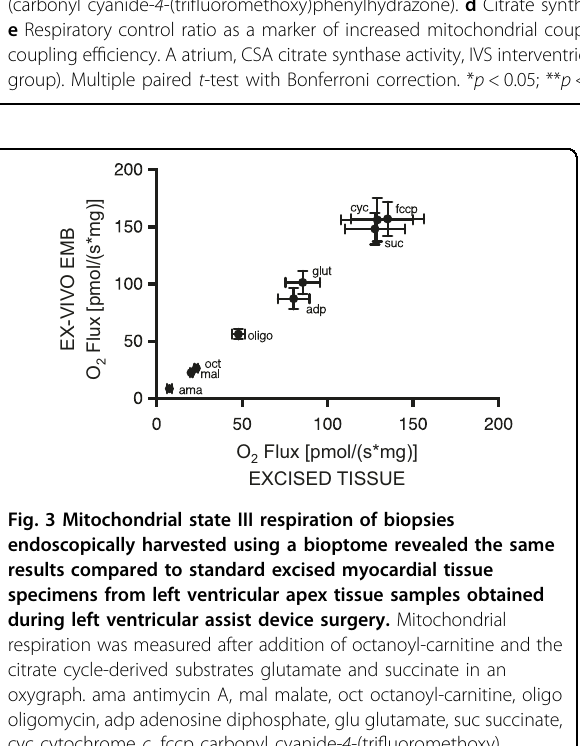
carnitine: r = 0.49, p < 0.001; octanoyl-carnitine + gluta- mate + succinate: r = 0.39, p < 0.05) (Fig. 4c, d), even after